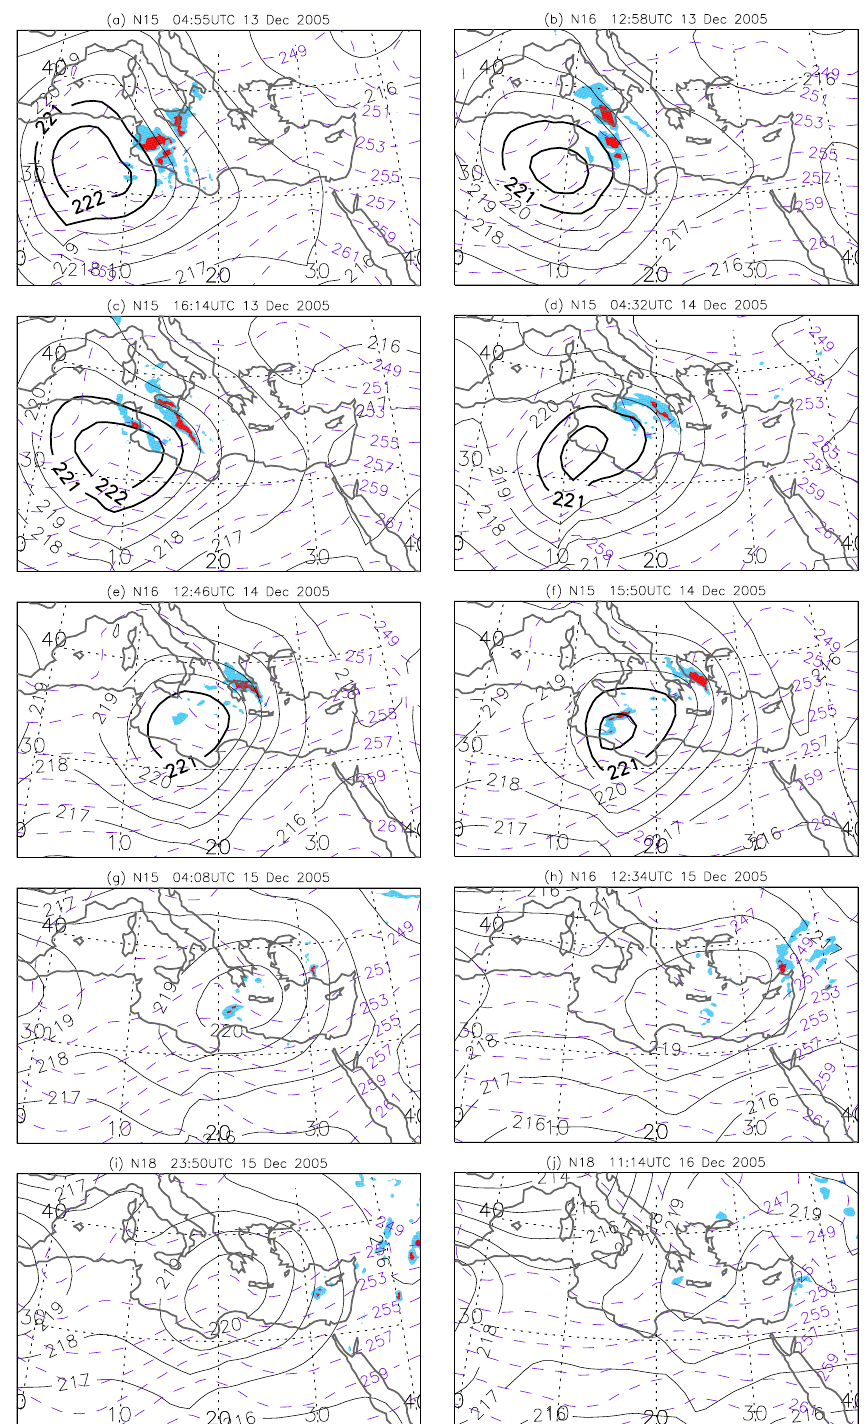
Fig. 14. Same as Fig. 7, but for: (a) NOAA-15, 13 December 2005, 04:55UTC, (b) NOAA-16, 13 December 2005, 12:58UTC, Figure 14 Figure 14 (c) NOAA-15, 13 December 2005, 16:14UTC, (d) NOAA-15, 14 December 2005, 04:32UTC, (e) NOAA-16, 14 December 2005, 12:46UTC, (f) NOAA-15, 14 December 2005, 15:50UTC, (g) NOAA-15, 15 December 2005, 04:08UTC, (h) NOAA-16, 15 December 2005, 12:34UTC, (i) NOAA-18, 15 December 2005, 23:50UTC, (j) NOAA-18, 16 December 2005, 11:14UTC. Note that A-5 isolines are displayed every